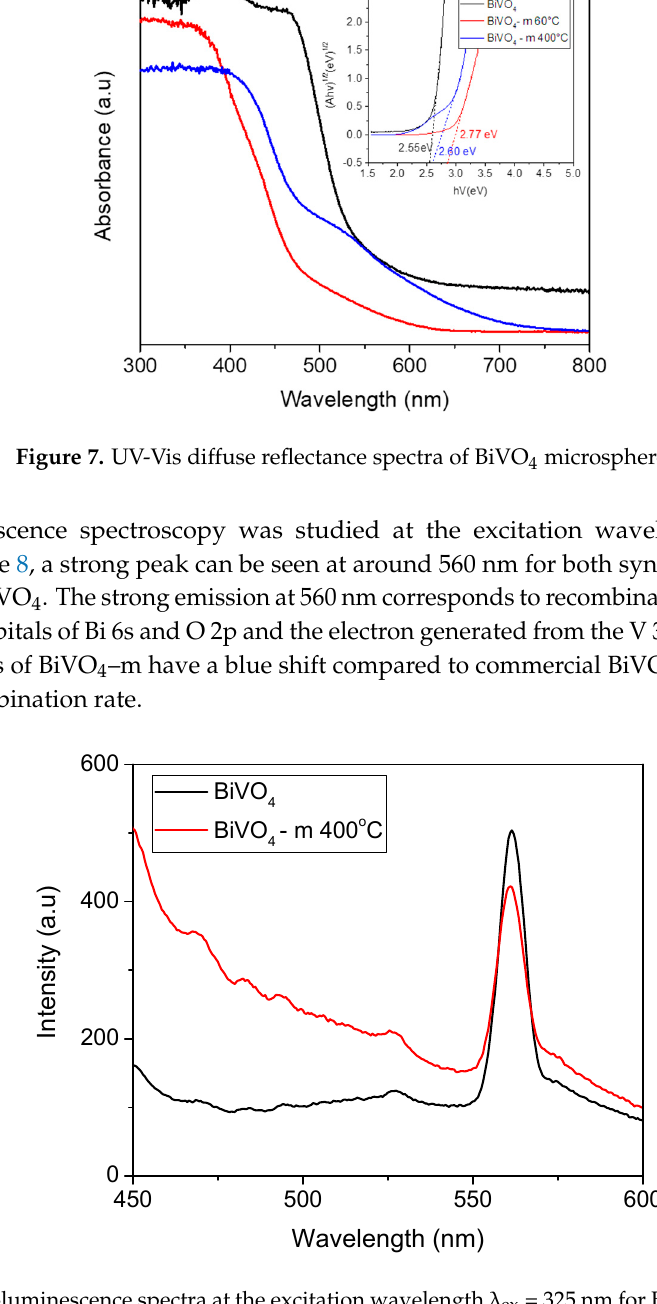
Figure 8. Photoluminescence spectra at the excitation wavelength λ ex = 325 nm for BiVO 4 microspheres at 400 °C.